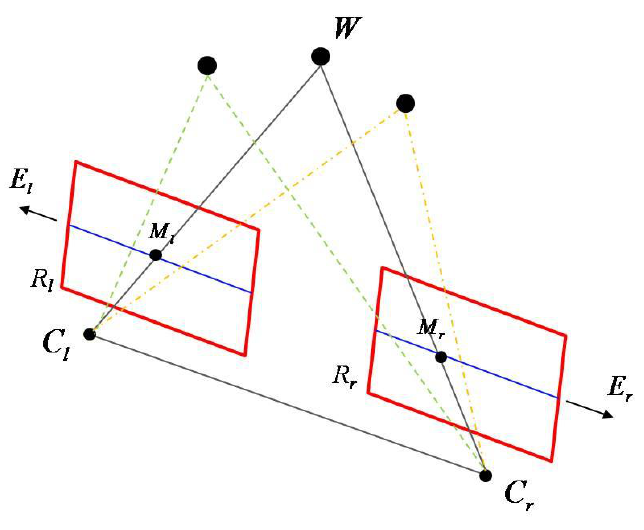
Figure 6. The standard setting of